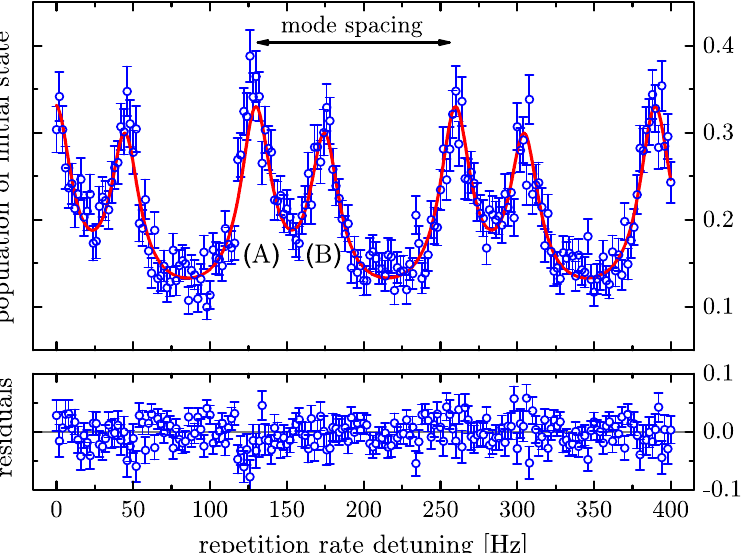
Figure 6. Typical spectroscopy signal obtained by Zeno spectroscopy with a frequency comb. The remaining population of the initial state after the spectroscopy period is plotted for different detunings, which is a measure of the strength of the QZE. The horizontal axis shows repetition rate detuning from 373, 258, 500 Hz. The repeating structure has a period that corresponds to the mode structure of the frequency comb. The red line shown is a fit with two Lorentzian curves (two transitions shown in Fig. 5) convolved with the comb spectrum. Poissonian noise is assumed for the fluorescence signal. Peaks at (A) and (B) correspond to 3 s 1/2 ( F = 3, M = 3) → 3 p 3/2 ( F = 4, M = 4) and 3 s 1/2 ( F = 2, M = 2) → 3 p 3/2 ( F = 3, M = 3) transitions